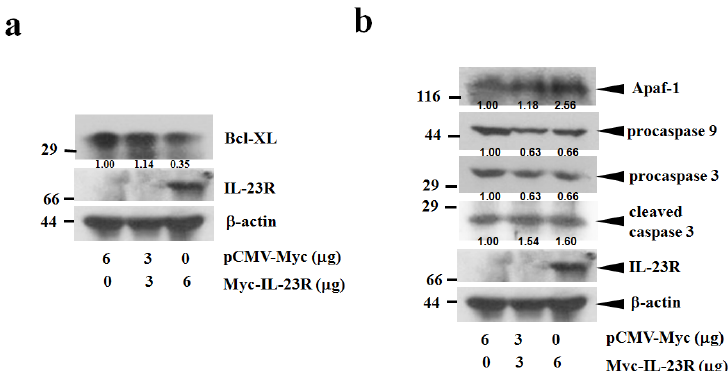
Figure 5. IL-23R mediated cell apoptosis in HeLa cells is also associated with mitochrondia mediated intrinsic pathway. ( a ) IL-23R inhibited Bcl-XL expression in a dose dependent manner; and ( b ) The cell lysates prepared from IL-23R transfected HeLa cells after 48 h transfection were probed with anti Apaf-1, anti caspase 9 and anti-caspase 3 antibodies and analyzed by Western blot analysis. β -actin gene expression was served as internal control. In both ( a ) and ( b ), the relative intensity of individual band was calculated based on the expression of β -actin by using the Quantity One